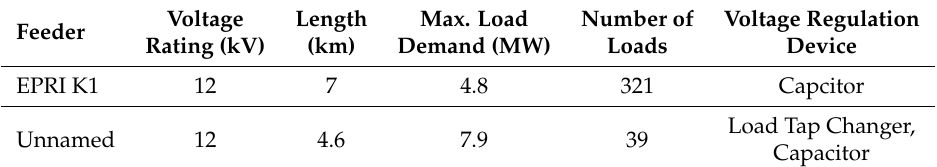
Table 1. Feeder characteristics.